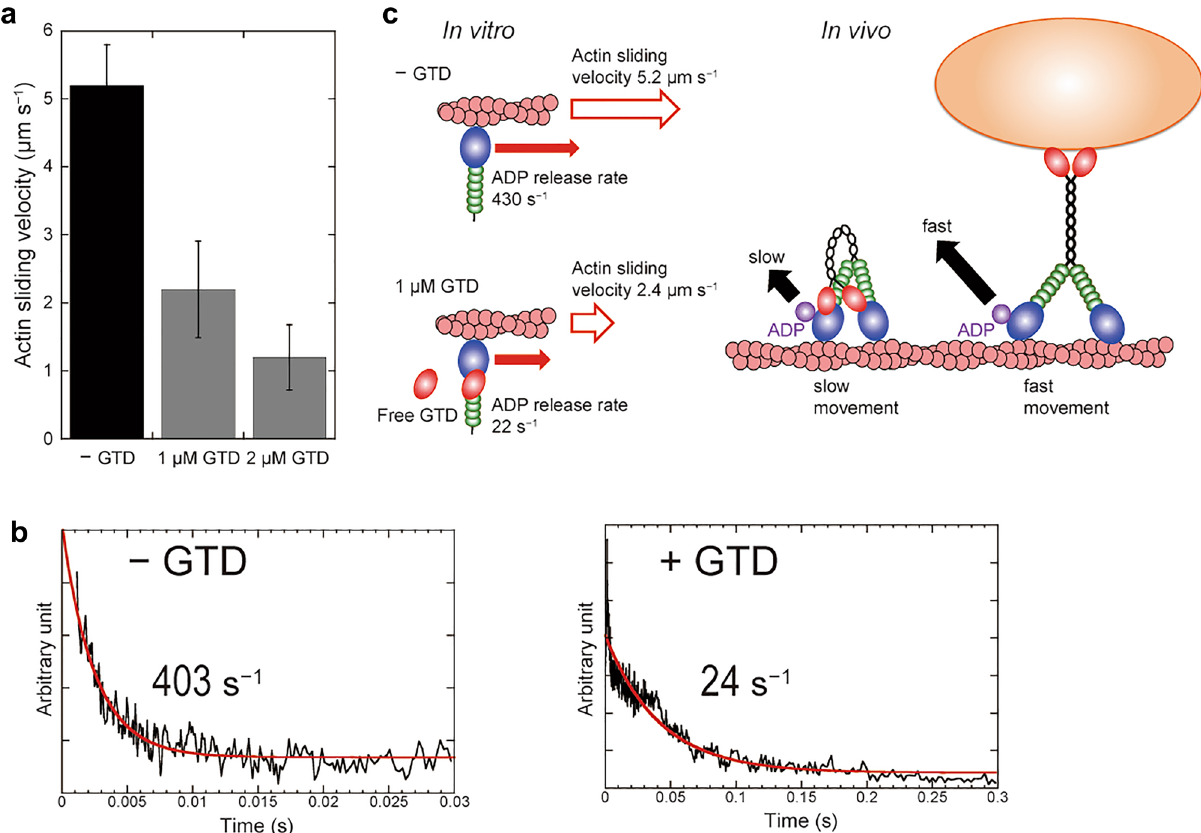
Figure 3. Inhibitory effects of actin sliding velocities of 6IQ and the dissociation rates of mant-ADP from 6IQ. ( a ) Inhibitory effects of actin sliding velocities of 6IQ by 1 µM GTD and 2 µM GTD in the presence of 3 mM ATP. ( b ) Mant-ADP dissociation from acto-6IQ in the presence of 1 µM GTD and absence of GTD. The dissociation rates of mant-ADP from 6IQ were measured using fluorescence energy transfer between the tryptophans of MD of 6IQ and mant-ADP. The transient shown is the average of six separate recordings. The red line is a single exponential fit yielding a rate constant of 403 s −1 in the absence of GTD (left) and 24 s −1 in the presence of 1 µM GTD (right). The average of three independent assays was 22 ± 3.4 s −1 in the presence of 1 µM GTD and 430 ± 40 s −1 in the absence of GTD. (c) A model of the mechanism by which GTD inhibits the movement of MYA2 in vitro and in vivo. In vitro, in the absence of GTD, the ADP dissociation rate of acto-6IQ is 430 s −1 and the actin sliding velocity of 6IQ is 5.2 μm s −1 . In the presence of 1 μM GTD, the ADP dissociation rate of acto-6IQ is 22 s −1 and the actin sliding velocity of 6IQ is 2.4 μm s −1 . In vivo, when GTD is not bound to the organelle, it interacts with MD and inhibits ADP dissociation from MD, thus slowing down the velocity of MYA2. In contrast, GTD is bound to the organelle, it does not interact with MD and thus does not inhibit MYA2